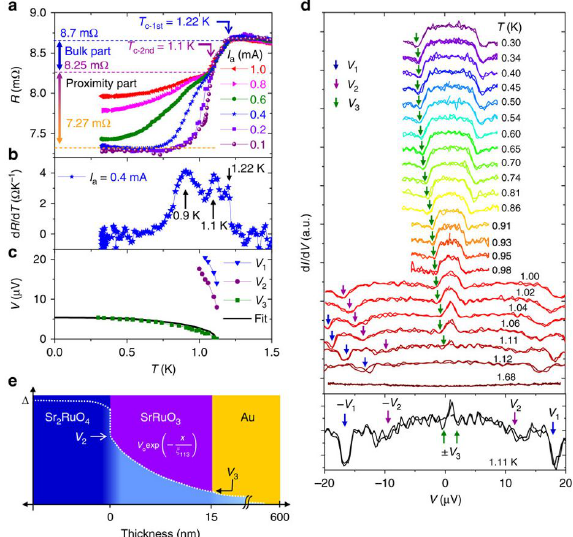
Figure 9. ( a ) Temperature-dependent resistance R ( T ) of a Au/SRO113/SRO214 junction in the range of 1.5–0.3 K, measured with different applied currents (0.1–1 mA). Two obvious transitions are observed; first, the robust applied current corresponds to bulk, and the second transition corresponds to the proximity effect. ( b ) dR / dT indicating various transitions in the junction. ( c ) Evolution of differential conductance dI / dV with temperature. ( d ) Voltage biased dI / dV at different temperatures. The curves are shifted vertically for clarity. The lower panel shows a dI / dV at 1.11 K to emphasise features. ( e ) A schematic illustration of the proximity effect in the junction. (Adopted with permission from [82] copyright NPG